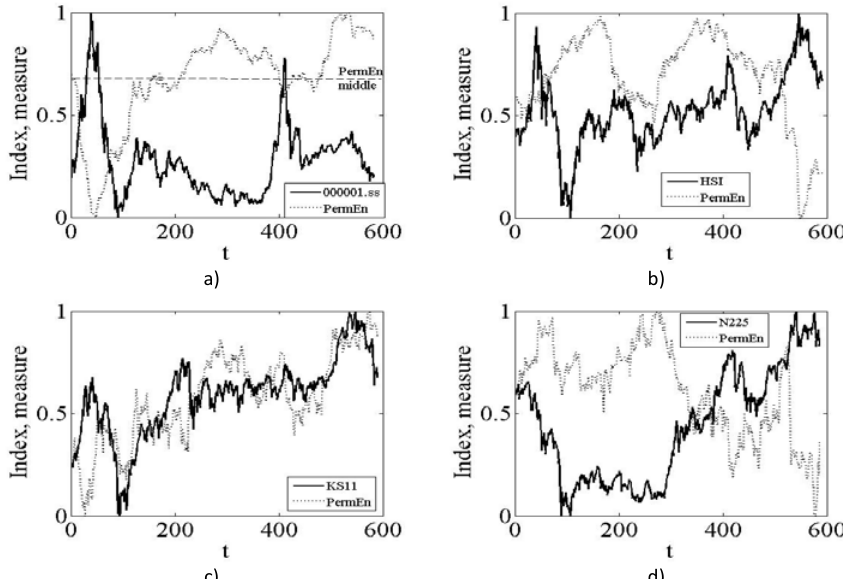
Fig. 4: Comparative dynamics of output series and permutation entropy for stock markets: (a) China, (b) Hong Kong, (c) Korea, (d) Japan